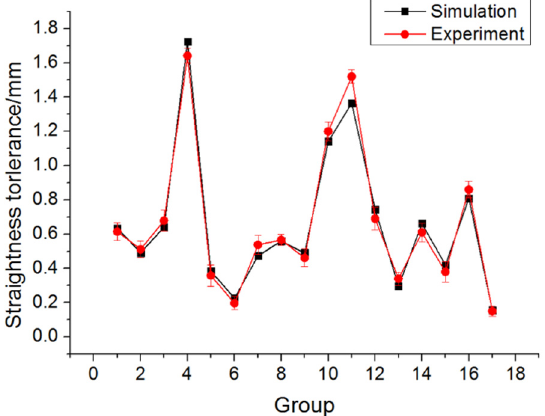
Figure 14. Comparison of experimental and simulation results of straightness tolerance.